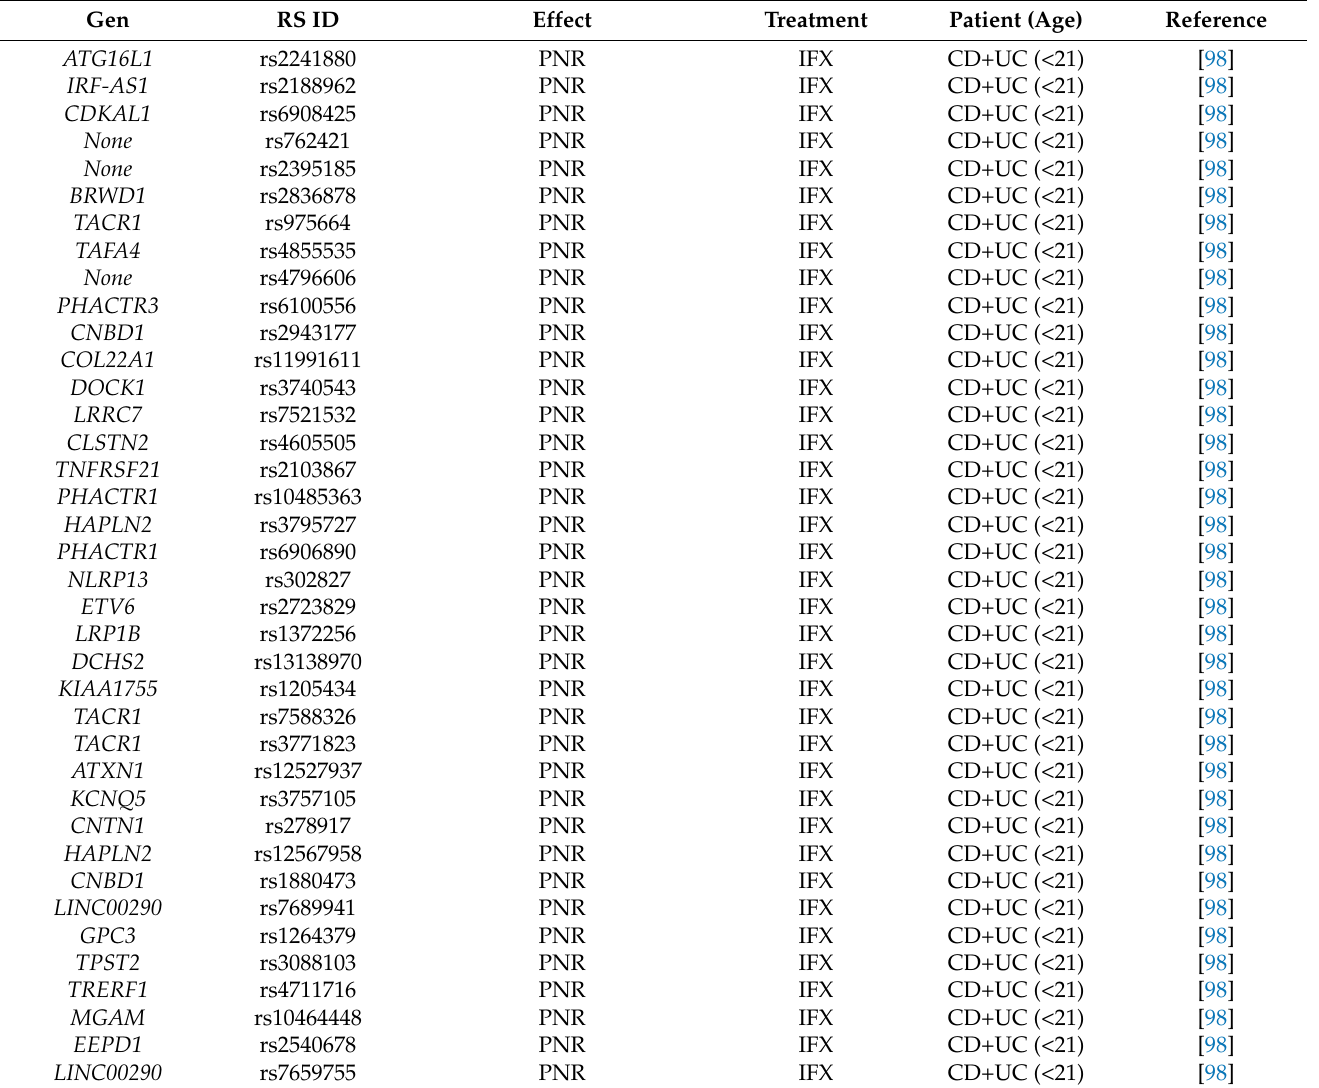
Table 1. Genetic variants associated with response or factors related to response to biological drugs in pediatric inflammatory bowel